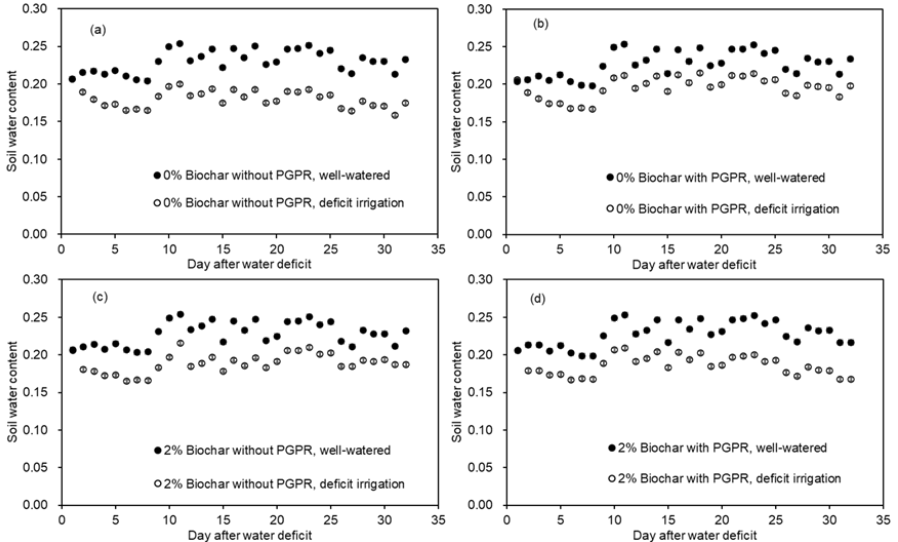
Figure 2. Changes of soil water content (%, g g − 1 ) in pots of potatoes exposed to two irrigation regimes with or without PGPR inoculation under two biochar amendments. ( a ) 0% biochar without PGPR; ( b ) 0% biochar with PGPR; ( c ) 2% biochar without PGPR; ( d ) 2% biochar with PGPR. The water amount for deficit irrigation was 70% of that of the well-watered ones.